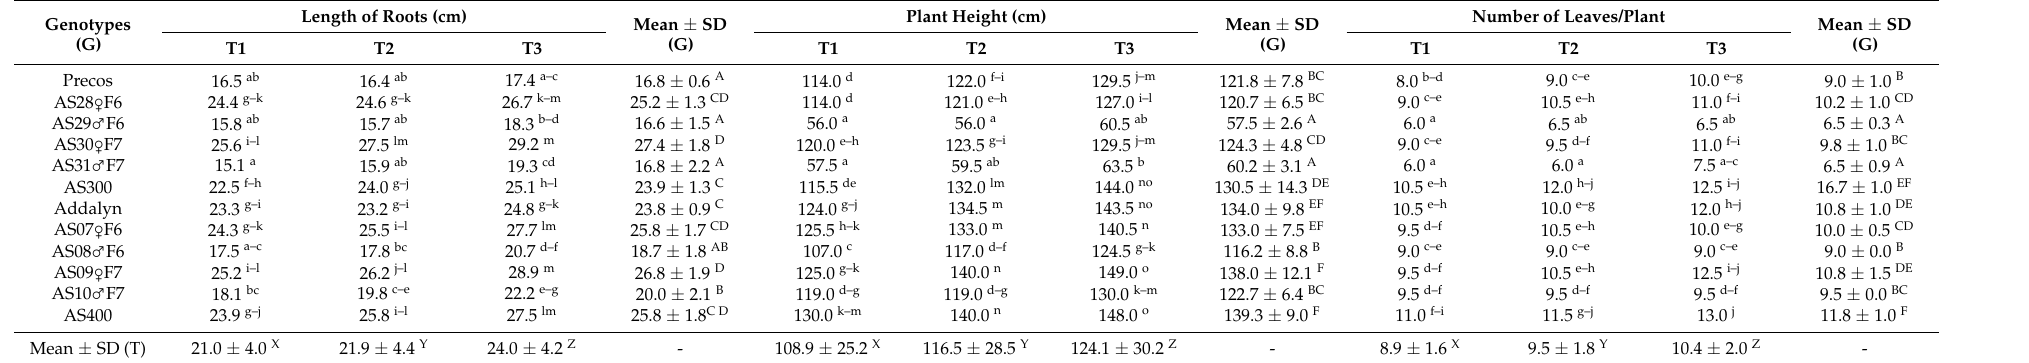
Table 3. The main characteristics of biomass of tomato plants according to genotype and